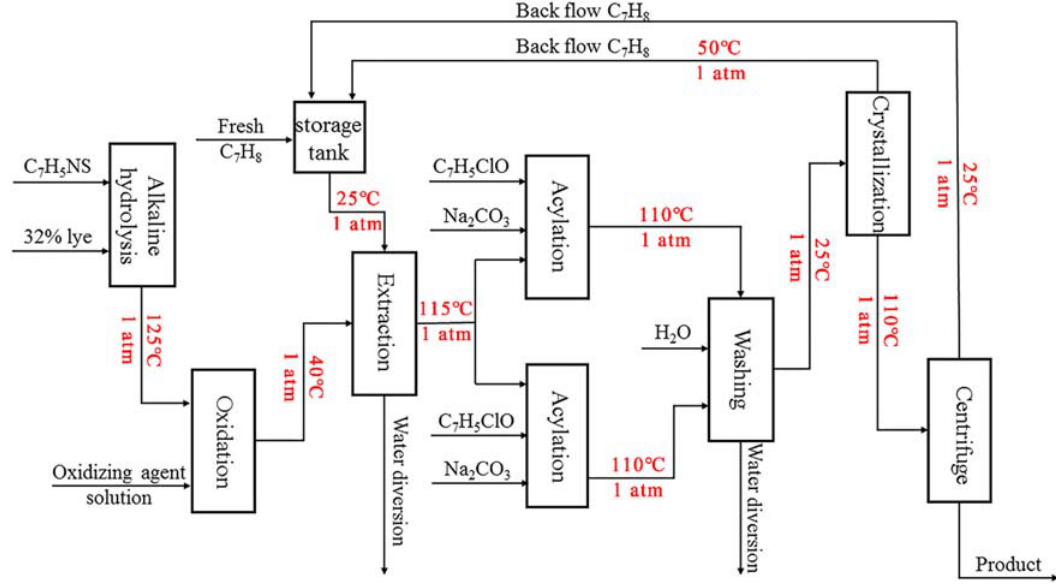
Figure 12: Diagram of the industrial process for producing DBD.